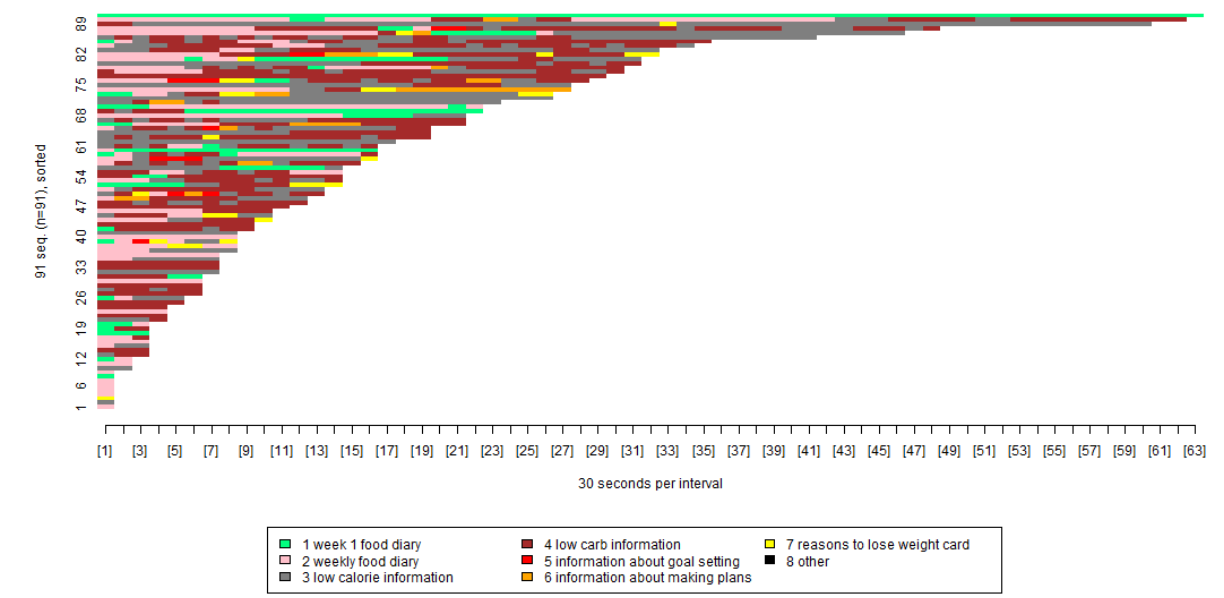
Figure 5. Visualization of participantsâ€™ repeated use of eating plan tools.